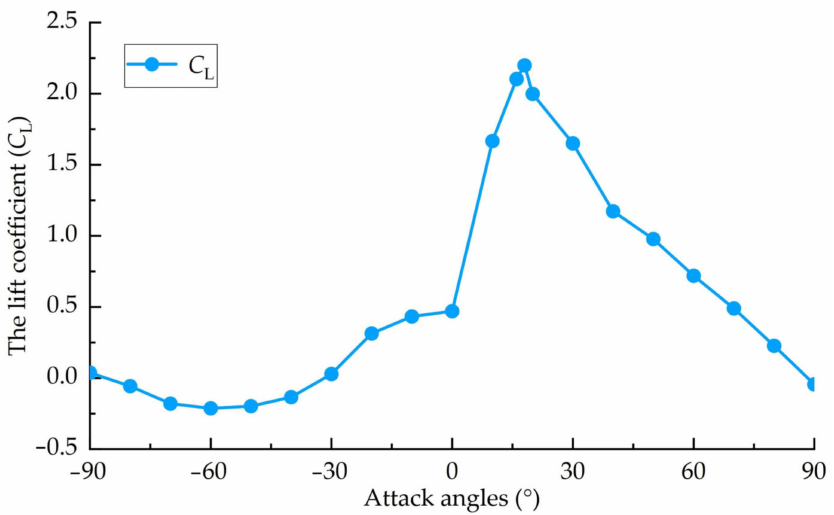
Figure 9. Lift coefficient at different attack